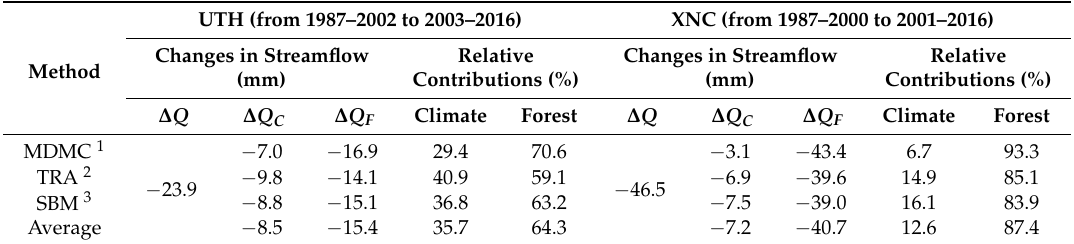
Table 6. Long-term annual streamflow changes and their components in UTH and XNC